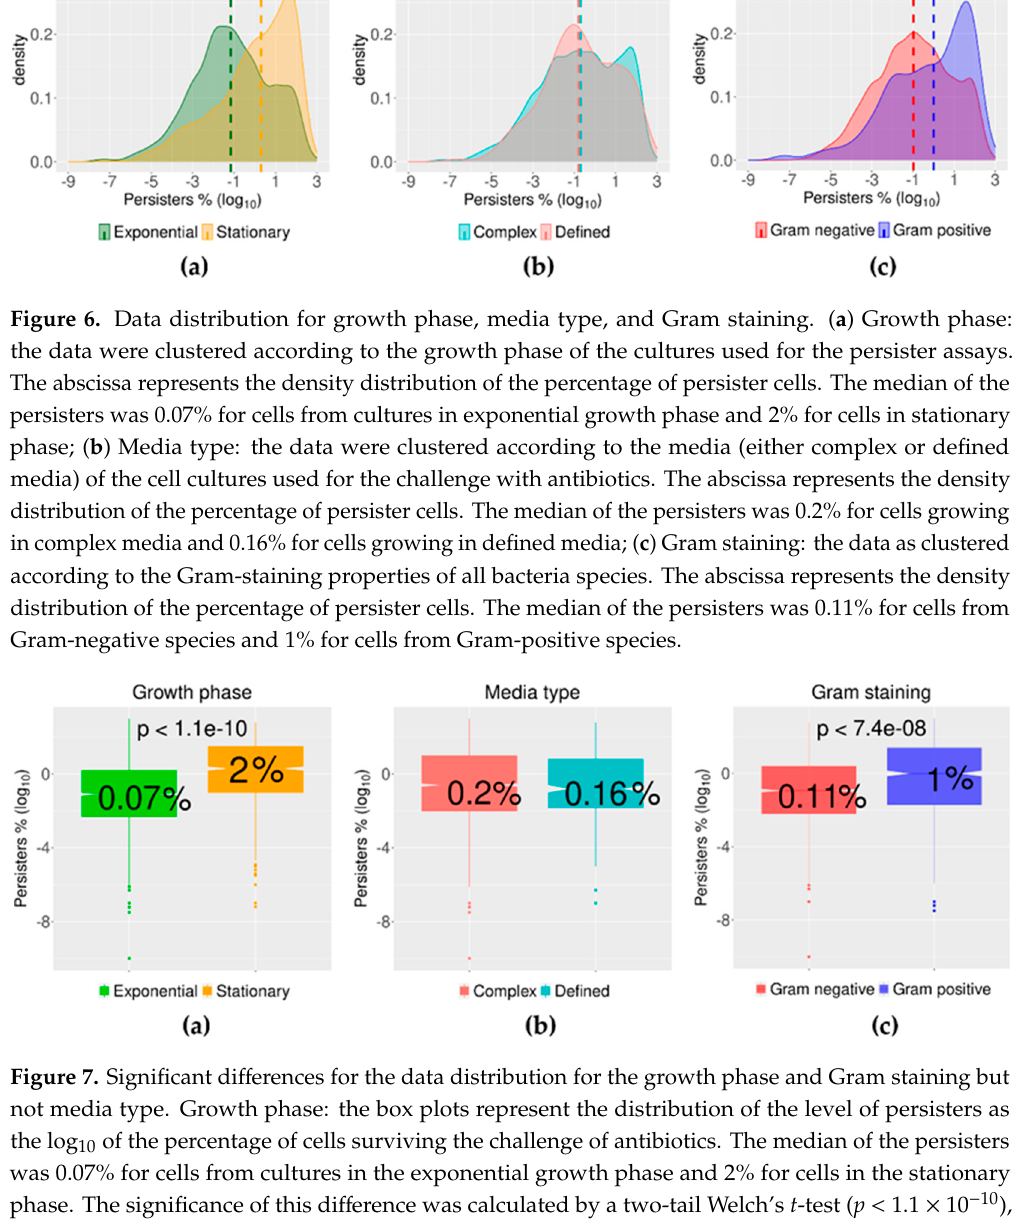
Table 3. Descriptive statistics for three of the variables measured for the incident of persisters in bacteria: The median, mean, and confidence interval 95% (CI95) were listed for the data grouped by growth phase, Gram staining, and growth media. The total number of data points collected from source are denoted as n .